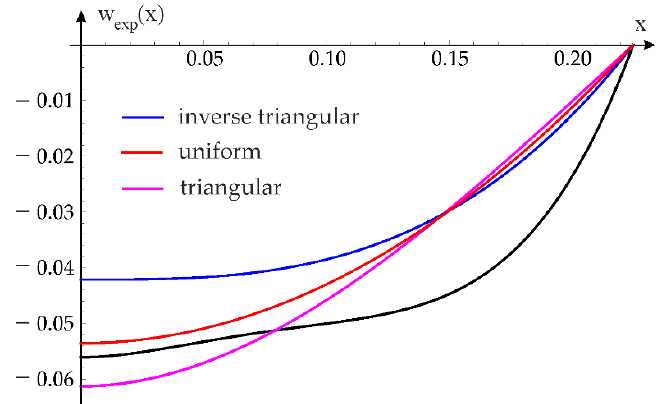
Figure 12. Comparison of deflection curves under the equivalent load distributed in the form of an inverse triangle, uniform and a triangle in view of the measurement results [9] of the reinforcement deflection curve (black line) for C_L and q av / J = 0.075.